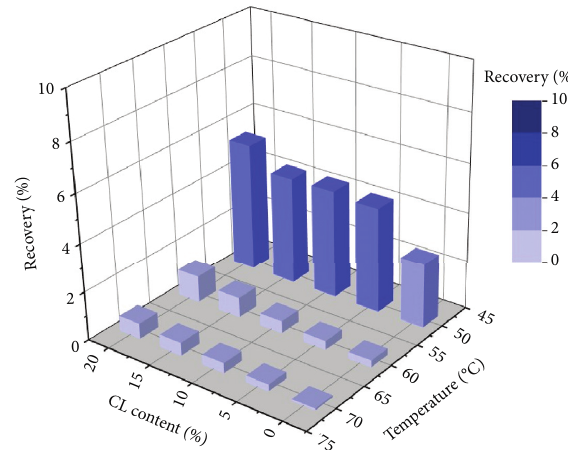
Figure 8: Variations in the percent recovery R at different test conditions under 3.2 kPa stress